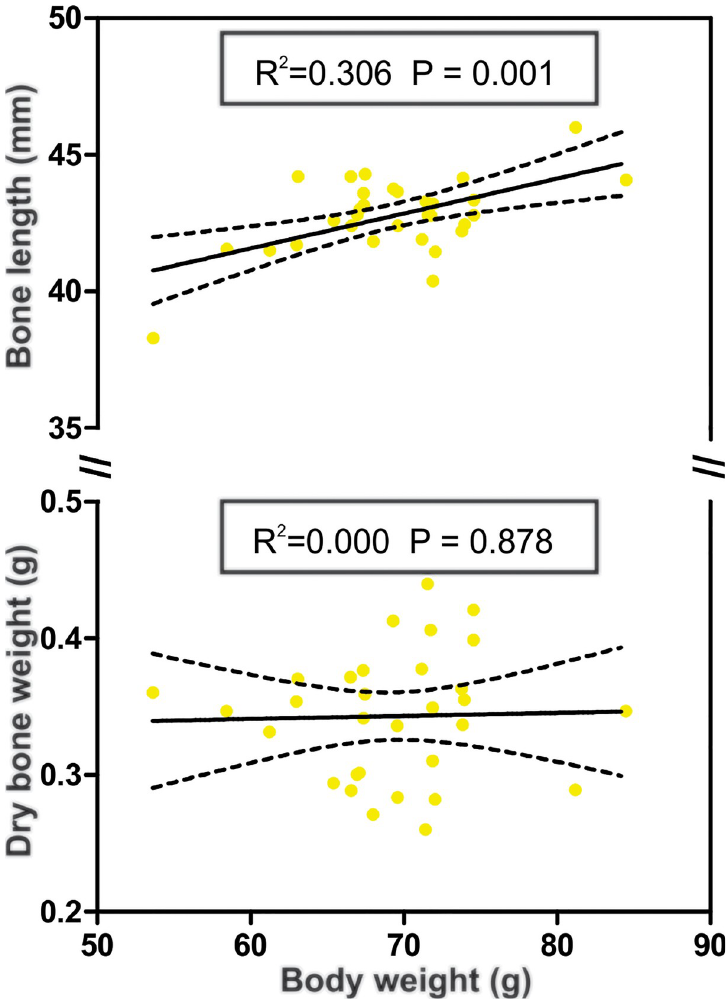
Fig 1. Correlations of body weight with bone characteristics in Artibeus lituratus females. Correlation between body weight and bone length (top) and between body weight and dry bone weight (bottom). Black lines represent regression line and dotted lines respresent lower and upper confidence limit (95%).